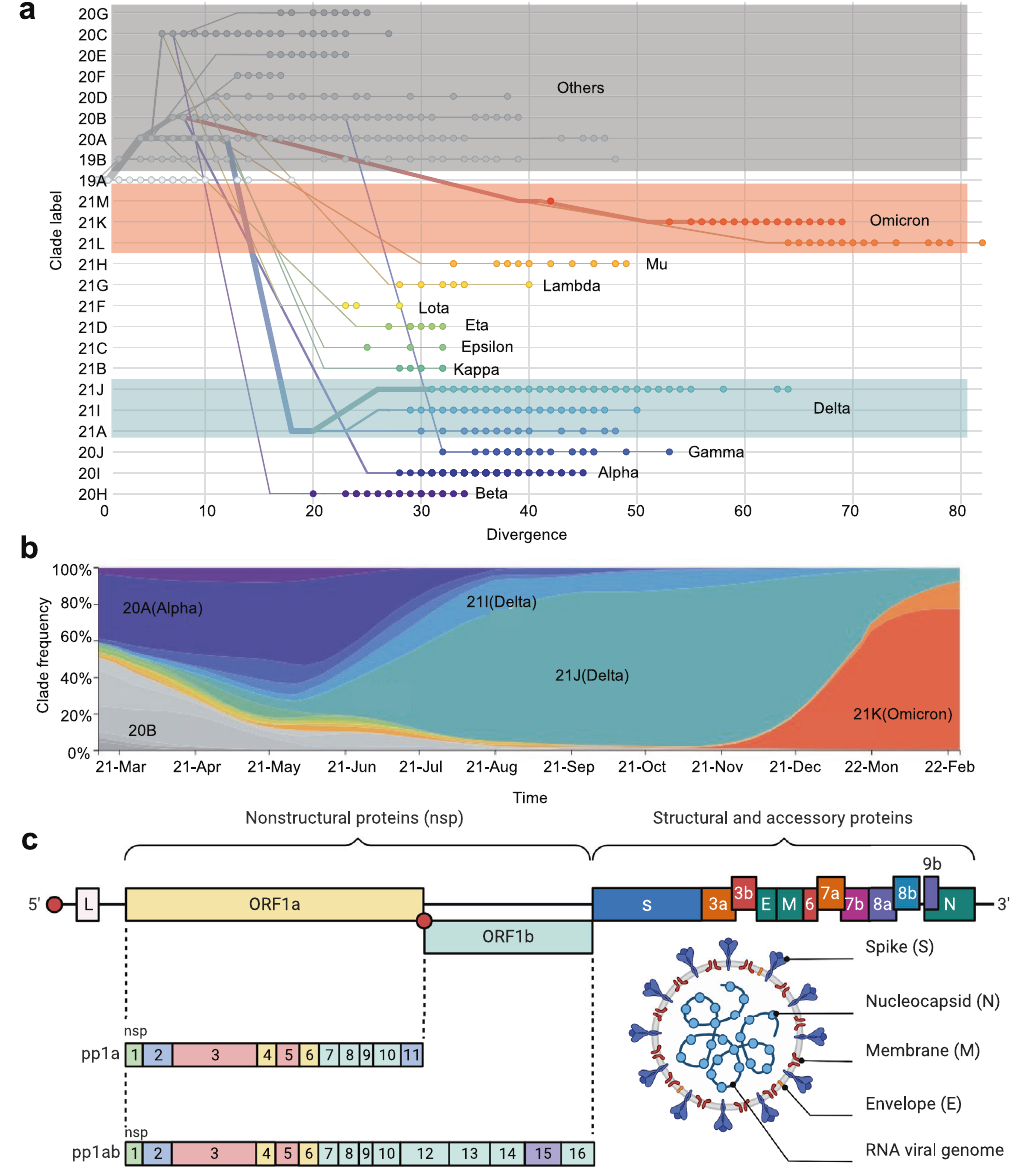
Fig. 1 SARS-CoV-2 evolution, prevalence, and genome architecture. a Phylogenetic analysis of sequence divergence of SARS-CoV-2 circulating variants based on clade classi fi cation in February 2022. The WHO labeling of clades is marked besides. b Sequential frequency of major clades of SARS-CoV-2 variants from April 2021 to February 2022. c Linear genome architecture of encoded viral protein and structural overview of SARS-CoV-2. The phylogenetic analysis and sequential frequency data come from the Nextstrain GISAID database (https://nextstrain.org/ncov/ gisaid/global), and fi gures in related ( a , b ) are generated under the CC-BY 4.0 permission. BioRender is used to generate the structure diagram of SARS-CoV-2 virus in Fig. 1c As the SARS-CoV-2 RNA genome encoded a set of structural and non-structural proteins (Fig. 1c), 62 – 65 the mutations in these